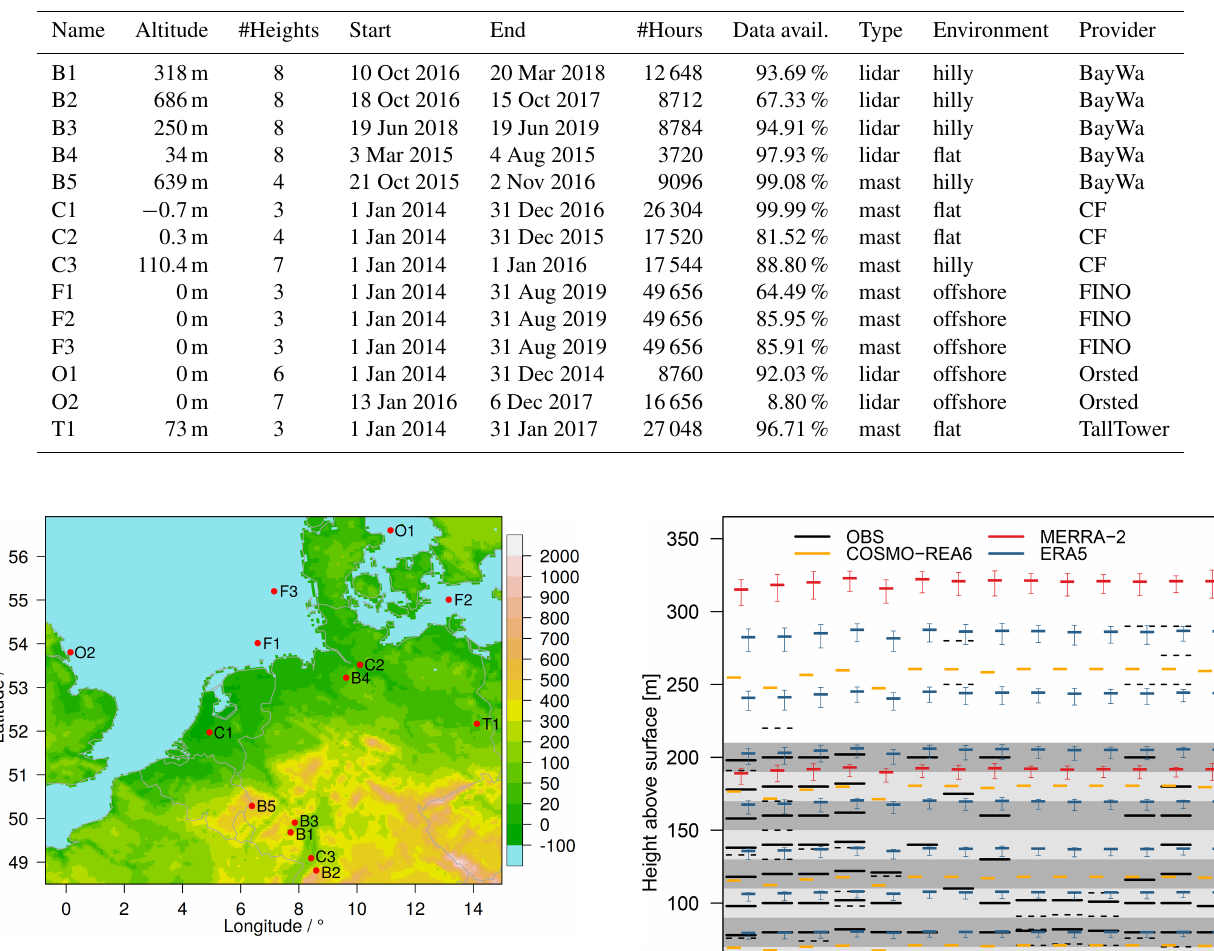
Table 1. Details of the 14 different measurement sites used in this study.